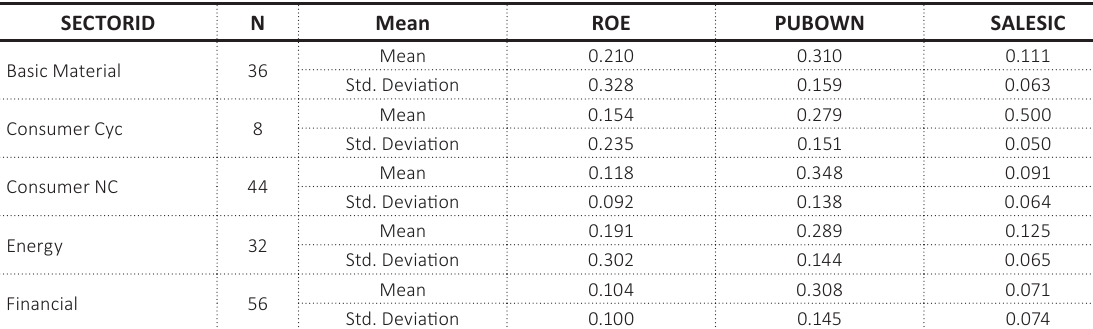
Table 5. Descriptive statistics (ROE, PUBOWN, SALESIC) by